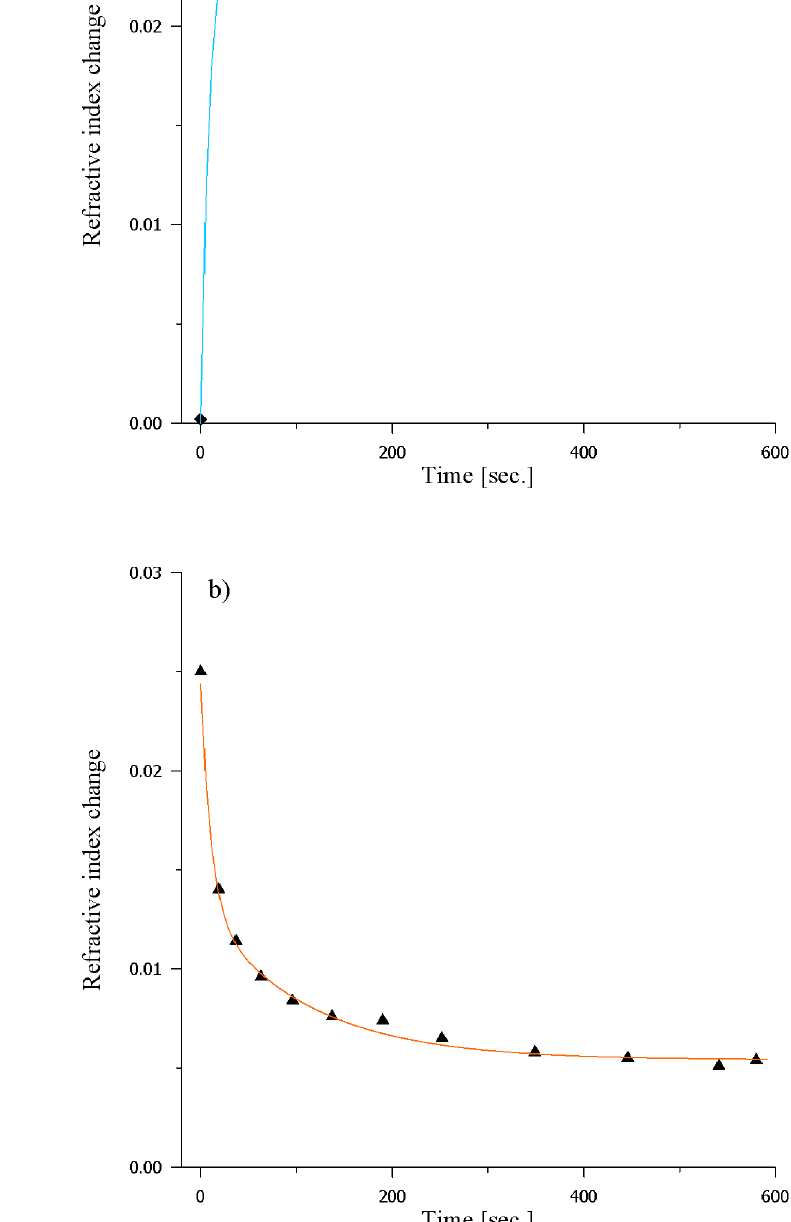
Fig. 7 Refractive index change for IZO-2/20MB. The solid line is a › t to biexponential functions a) for growth-light on b) for decay after the light was turned